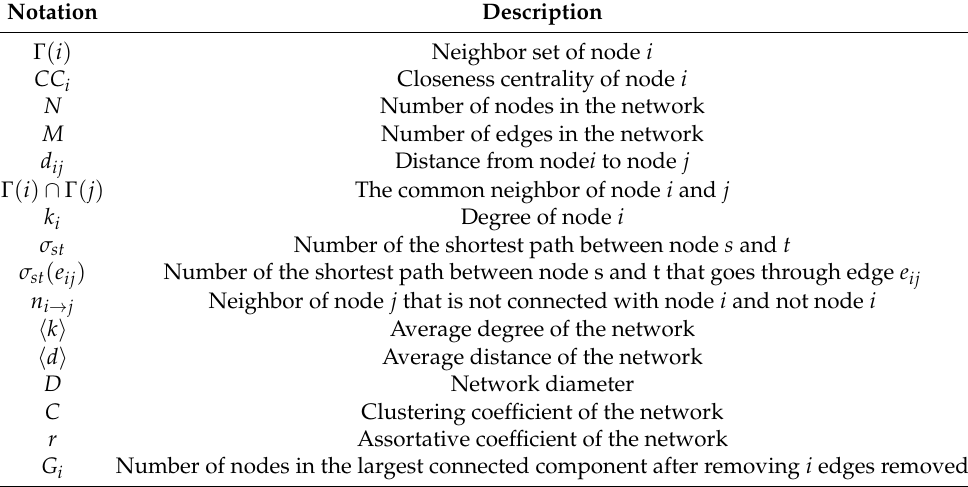
Table 1. Used symbols and